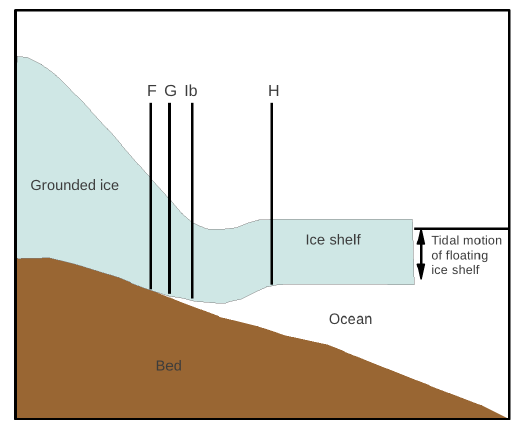
Figure 2. Important points along the transition between grounded and floating ice: F represents the landward limit of tidally induced vertical displacements; G is the grounding line where the ice bot- tom actually separates from the ground; Ib is the so-called “break in slope”; and H is the limit where the rigid effects of the elastic bending of the ice slab do not propagate any further, allowing the ice to freely float on the ocean (adapted from Brunt et al.,